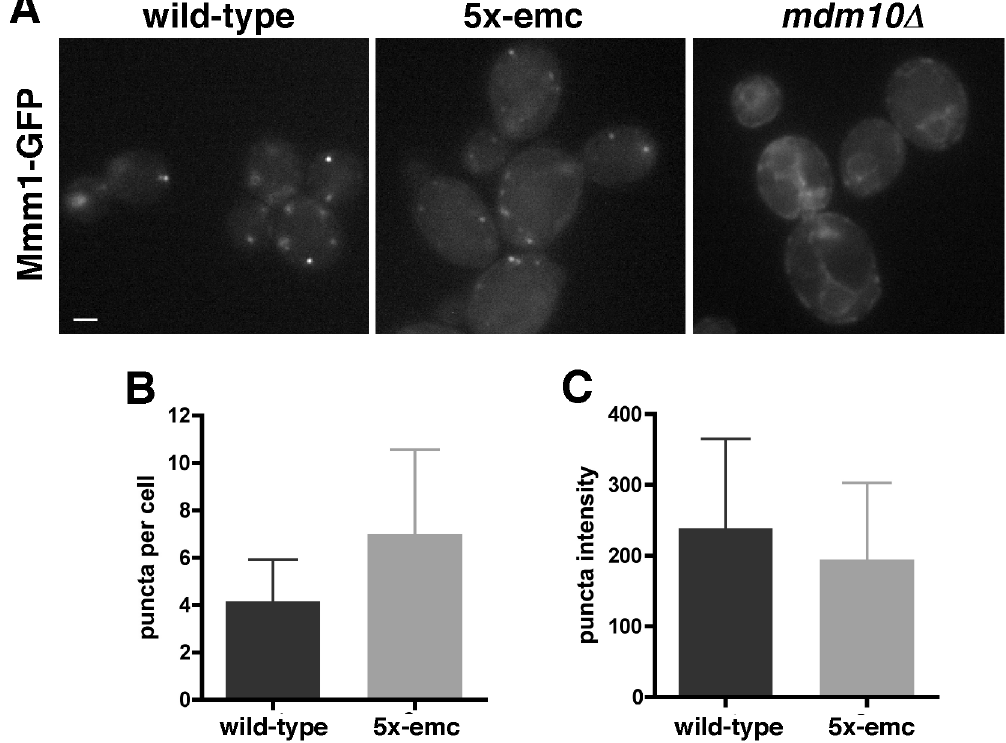
Figure 8. Formation of ERMES complex is not altered in 5x-emc cells. (A) Images of wild-type, 5x-emc, or mdm10D cells expressing Mmm1– GFP on the chromosome. Scale bar, 1 m m. (B) Number of puncta per cell in the indicated strains (mean 6 s.d., n =80 cells). (C) Average intensity of puncta in the indicated strains (mean 6 s.d., n =80 cells). * p , 0.05 compared to wild-type, independent two-tailed t test. The data used to generate panels B and C are in Table